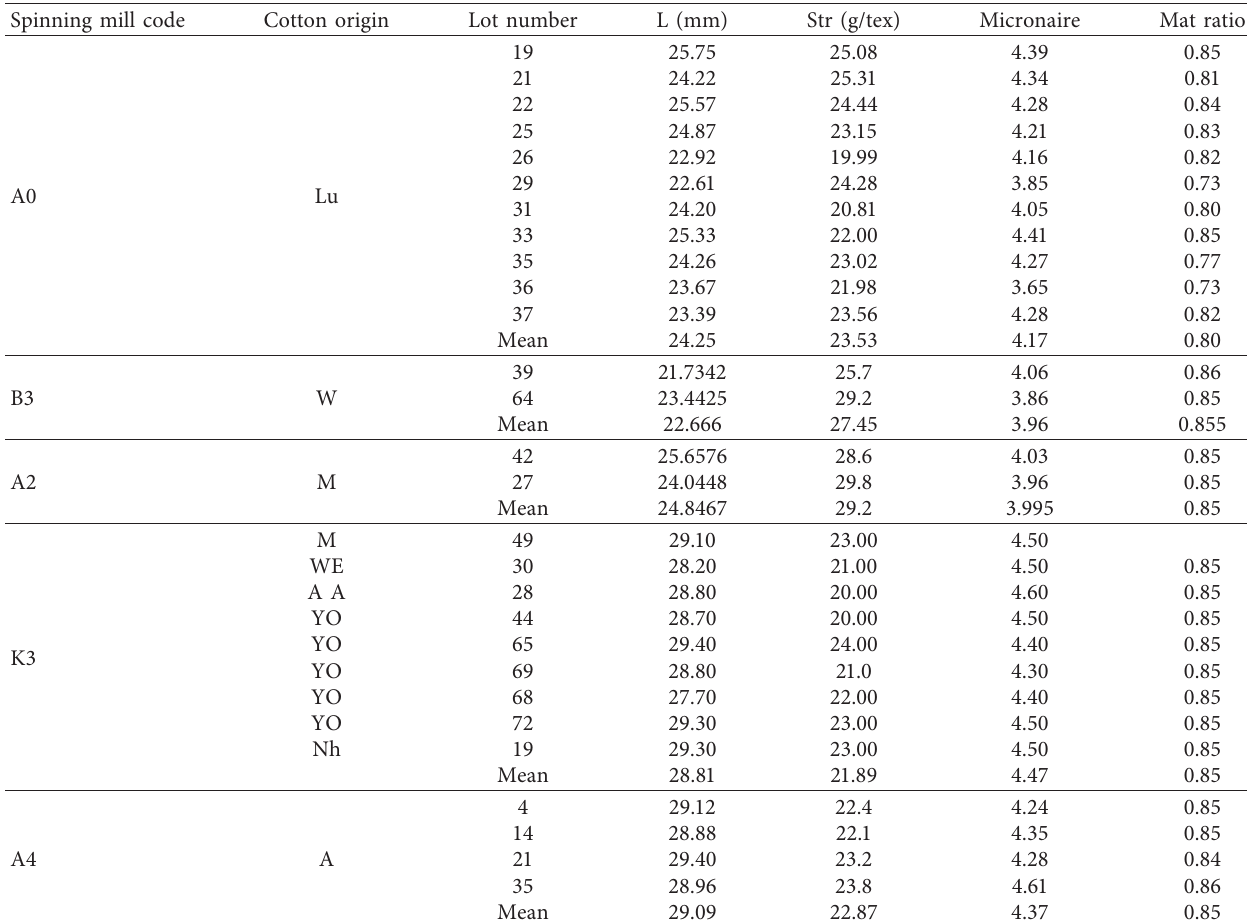
Table 2: Characteristics for cotton lint.